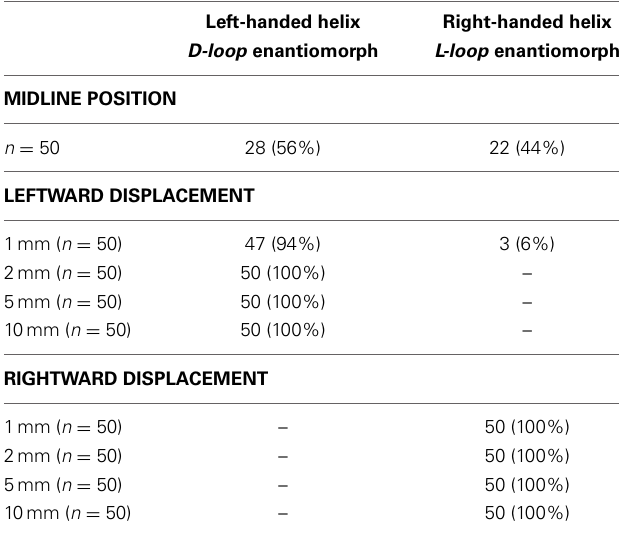
Table 1 | Relations between pre-buckling positions of the “caudal” end of the silicone rod and the directionality of helical